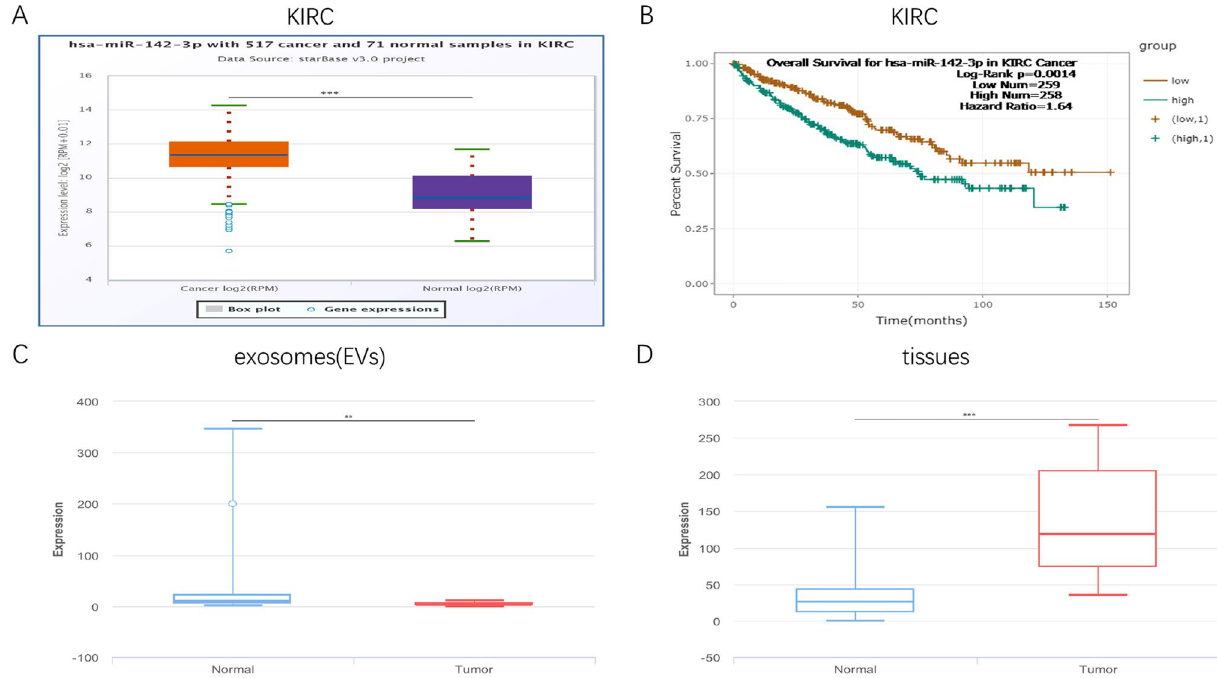
Figure 1. Expression pattern of miR-142-3p in clinical samples. Expression of miR-142-3p in KIRC ( A , P < 0.001) samples compared to adjacent normal tissues. Kaplan–Meier survival curves analysis for patients in TCGA KIRC ( B , P < 0.01) cohort (Orange = low, Blue = high). Expression of miR-142-3p in renal tumor patients in EVs ( C , P < 0.01) and tissues ( D , P < 0.001) compared to normal